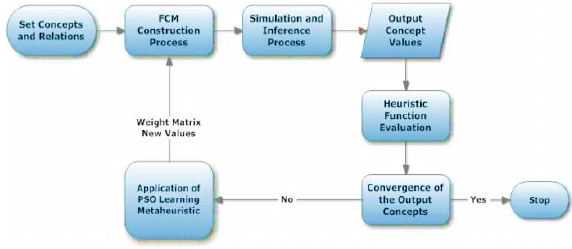
Fig. 5. Idea of using PSO for readjusting an